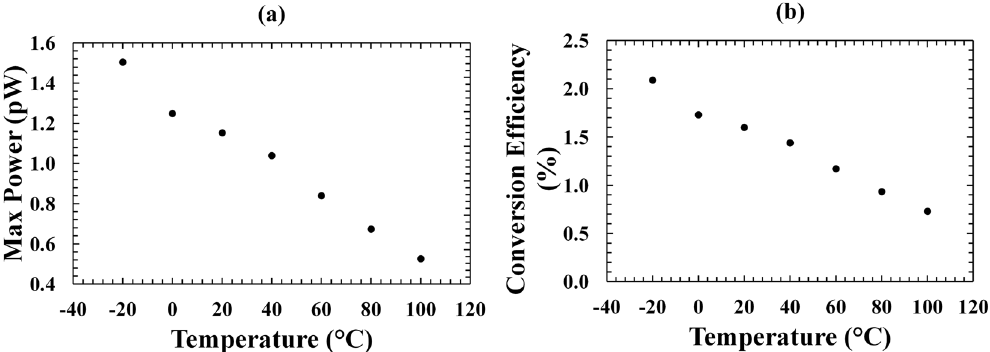
Figure 7. ( a ) Experimental maximum output power as a function of temperature for the 55 Fe X-ray photovoltaic In 0.5 Ga 0.5 P cell. ( b ) Conversion efficiency ( η ) as a function of temperature for the In 0.5 Ga 0.5 P 55 Fe X-ray photovoltaic